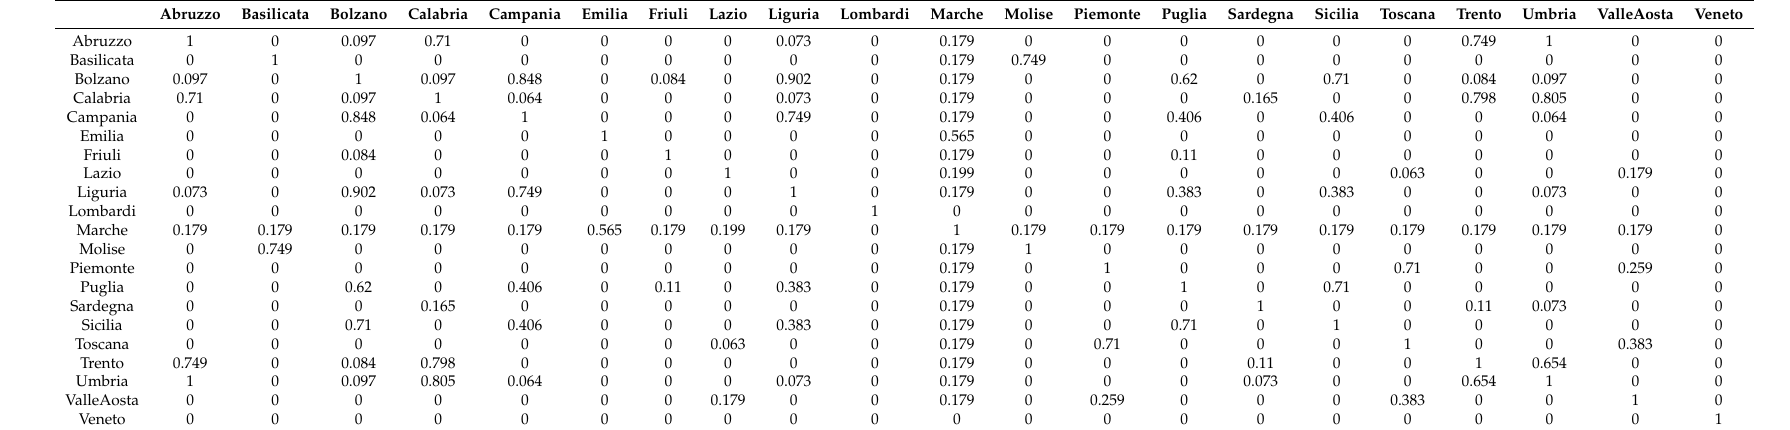
Table A59. Similarity values of Swabs network in the fourth week.